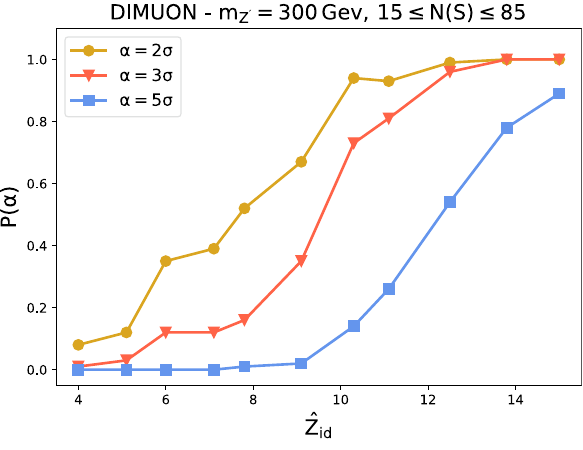
Fig. 3 Probability of finding a α = 2 σ, 3 σ, 5 σ evidence for new physics as a function of the ideal